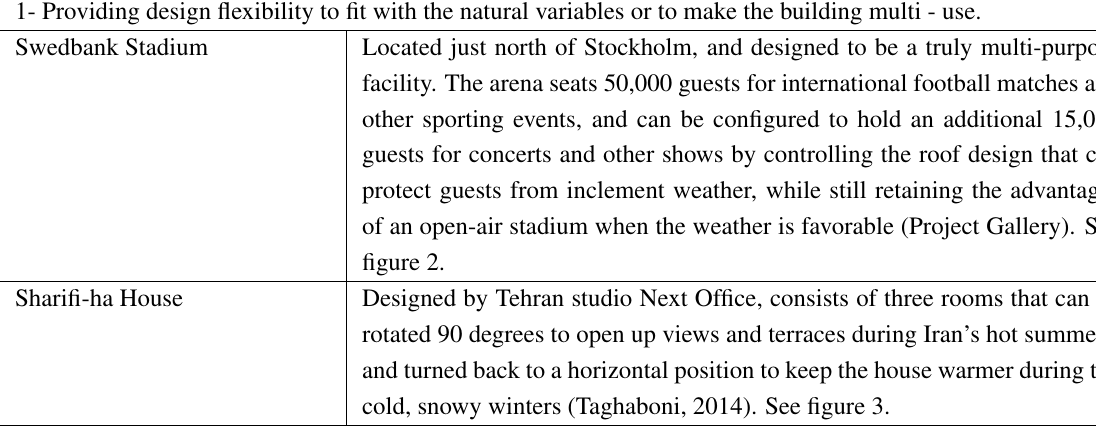
Table 1. Kinatic building examples for different purpose of